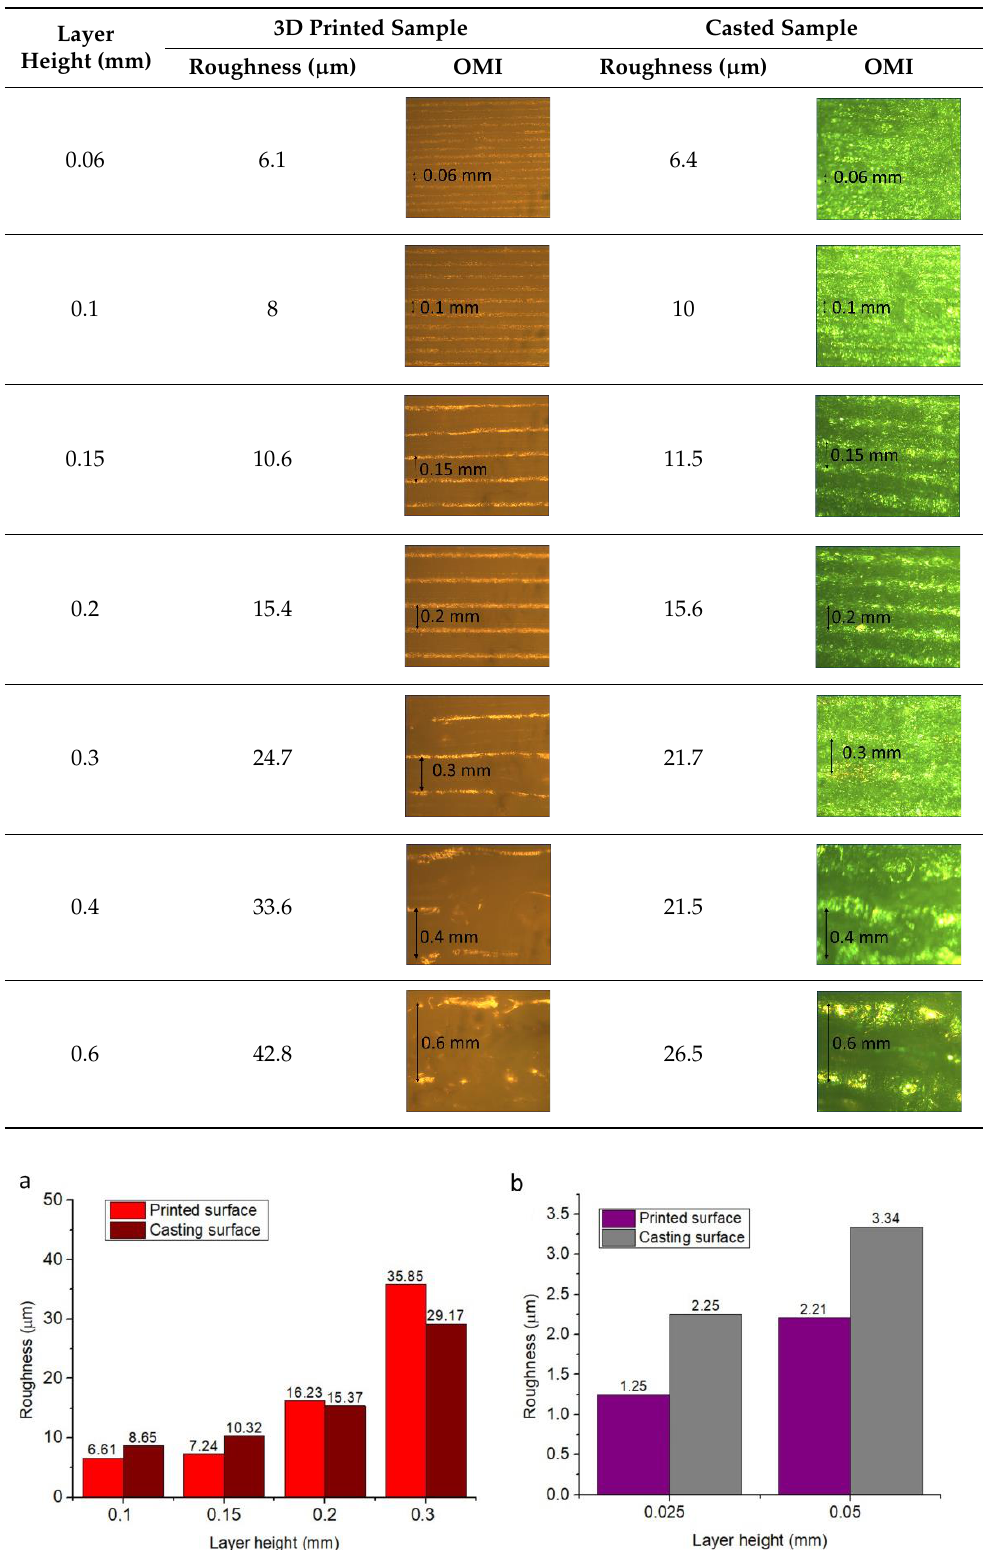
Figure 8. Influence of layer thickness on the surface roughness parameter Ra in the 3D – printed and casted parts. ( a ) Using the PVB pattern. ( b ) Using the CW pattern.